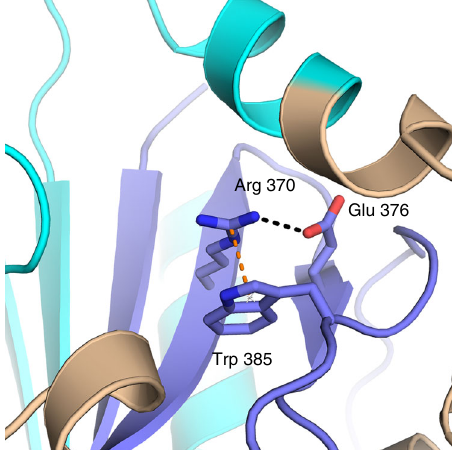
Fig. 5 Molecular interaction in direct contact with Arg370. Glu376 is forming a charged hydrogen bond to Arg370 (dashed black lines), while Trp385 is linked through a cation- π interaction (orange dashed line). The fi gure was prepared with The PyMOL Molecular Graphics System, Version 1.8 Schrödinger, LLC, and the modeling based on an alignment of the AE1 and AE3 sequence in the cytoplasmic region using PDB ID entry 1HYN